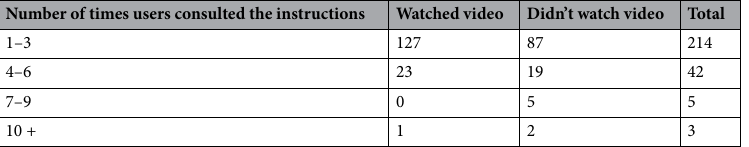
Number of times users consulted the